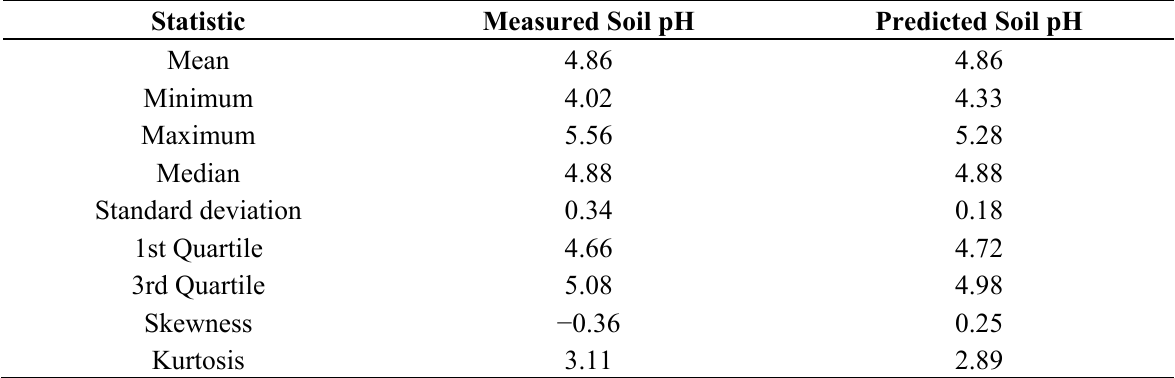
Table 1. Summary statistics for measured and predicted soil pH.